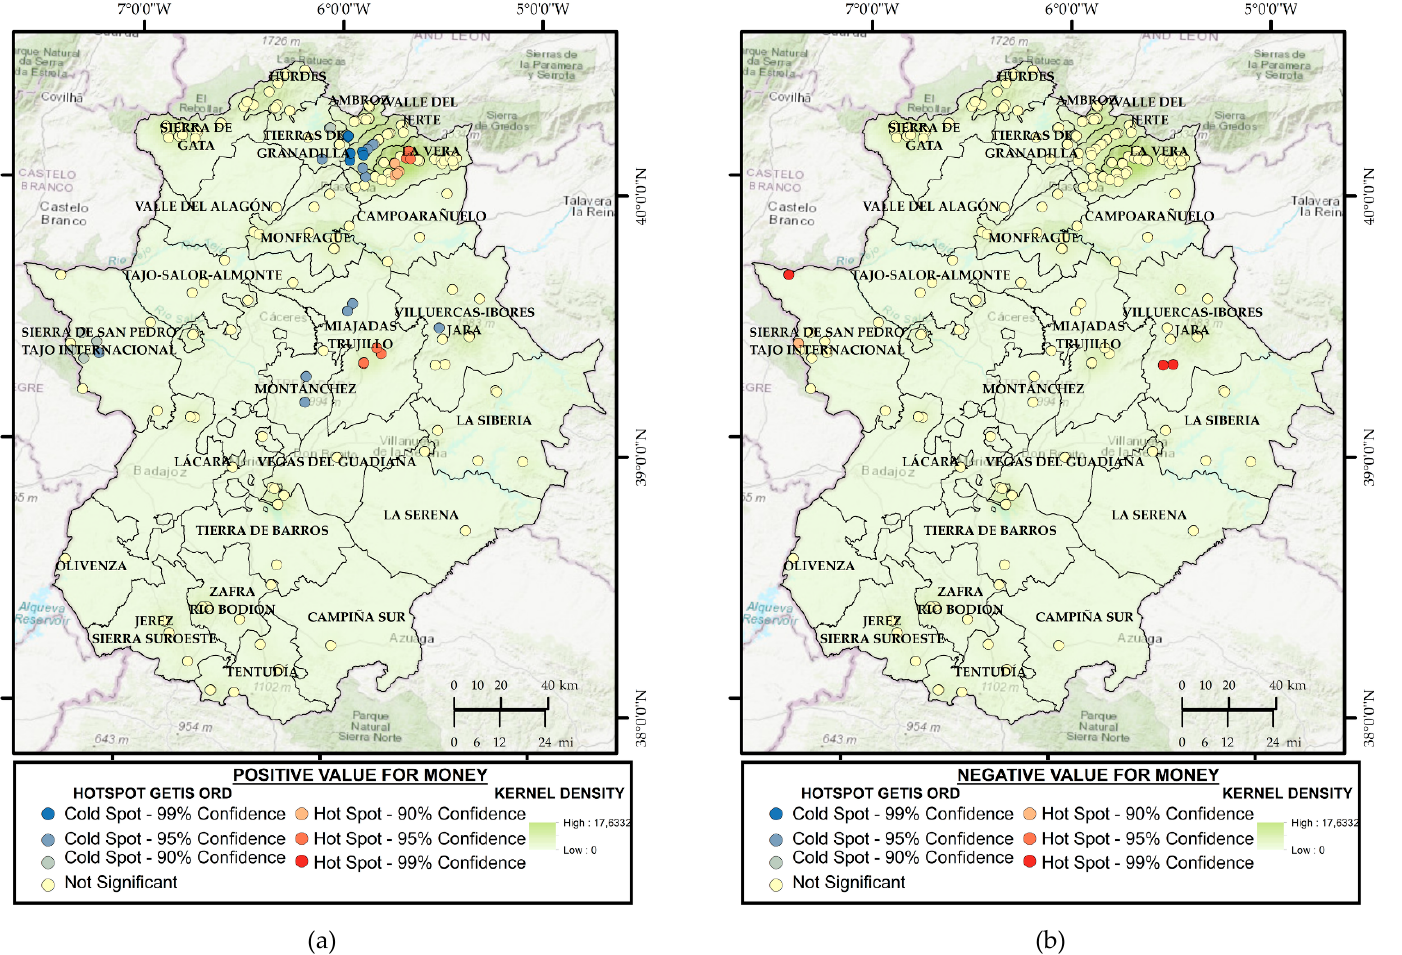
Figure 5. Gi* Getis Ord test on Value for Money Positive ( a ) and Negative ( b ) mentions.